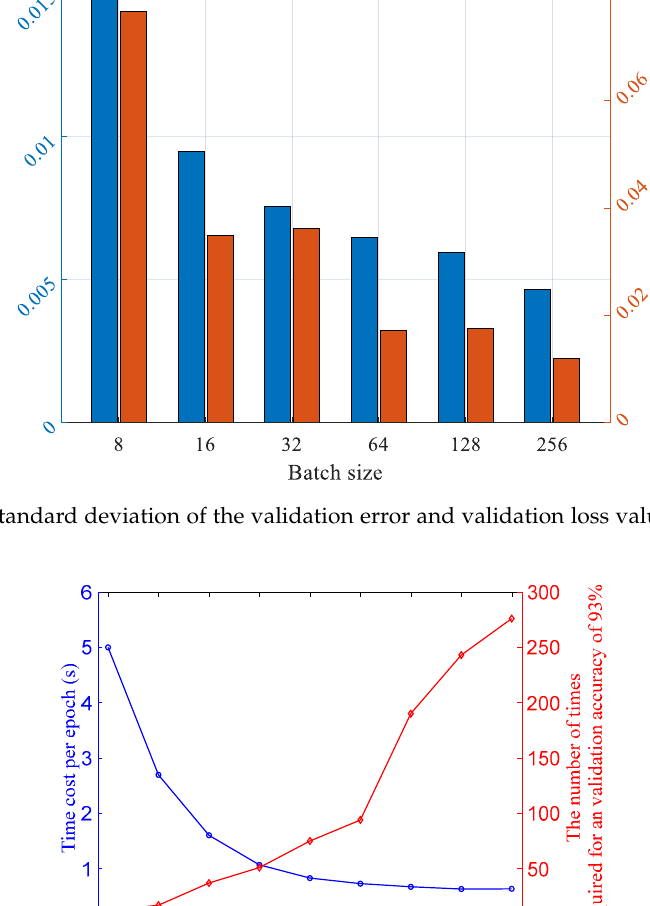
Figure 13. The effect of the batch size on the convergence process of the validation error.